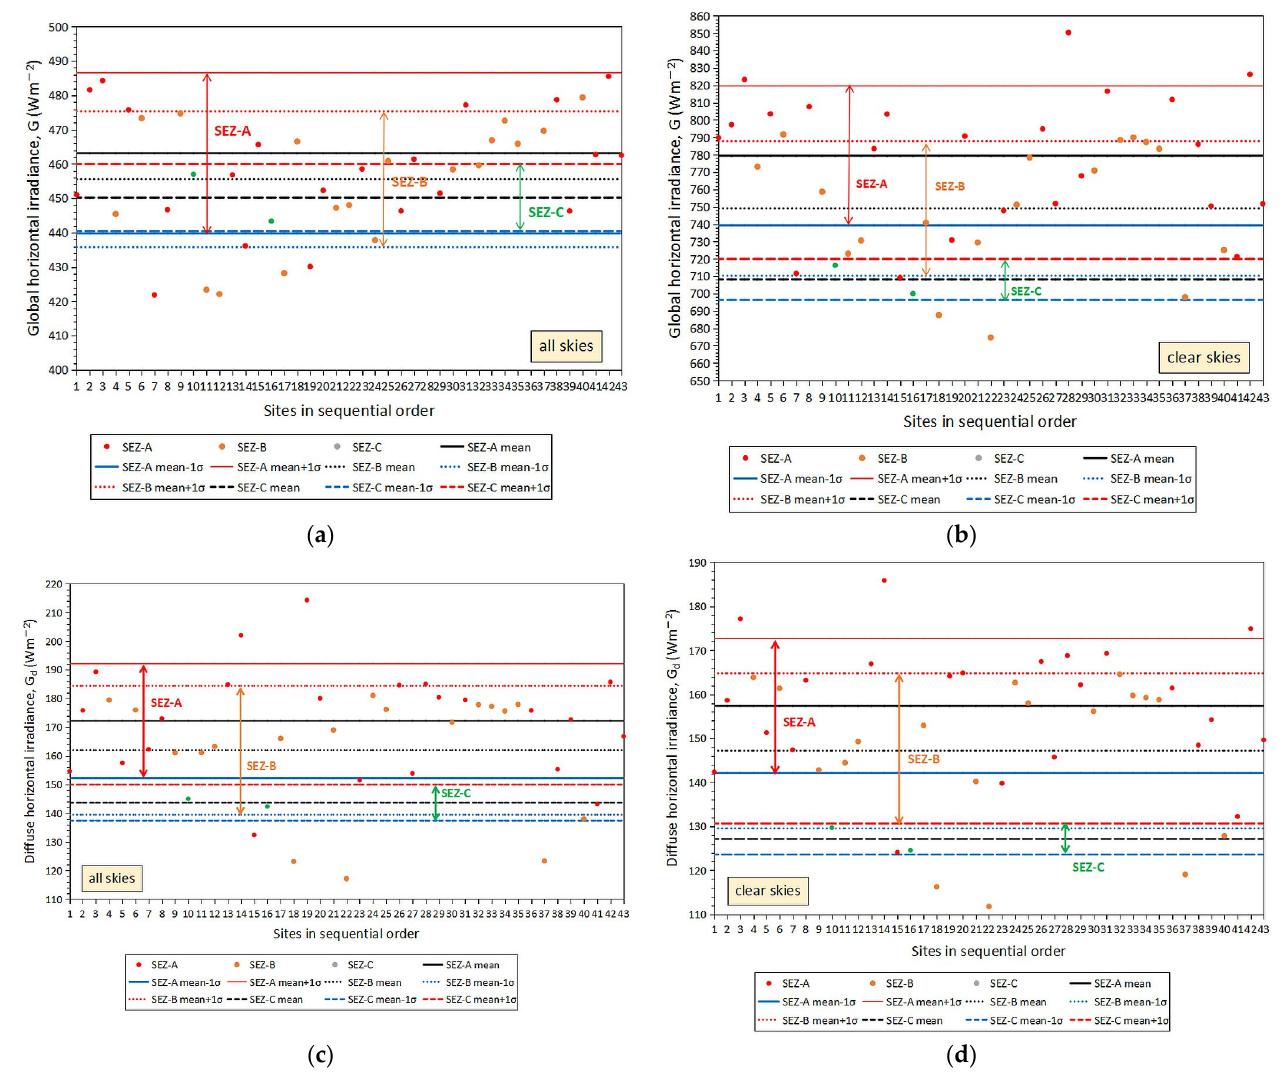
Figure 2. Annual mean ( a ) G and ( c ) G d values for all-sky and annual mean ( b ) G and ( d ) G d values for clear-sky conditions over Saudi Arabia in the period 2013–2021. The data points are colored according to the SEZ to which they belong (Table 1 and Figure 1). The ±1 σ range around the mean value for each SEZ is shown by a vertical double-arrow line in the same color as the SEZ. All plots were derived with the MICROSOFT’s Excel 2021